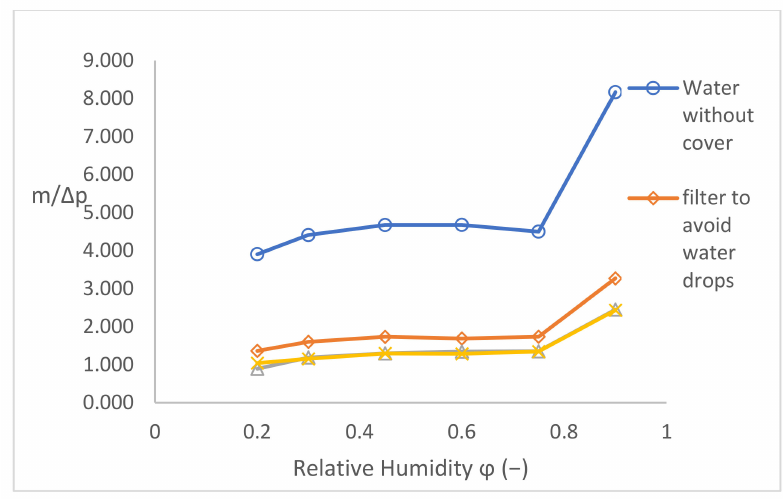
Figure 15. Validation parameter m/ ∆